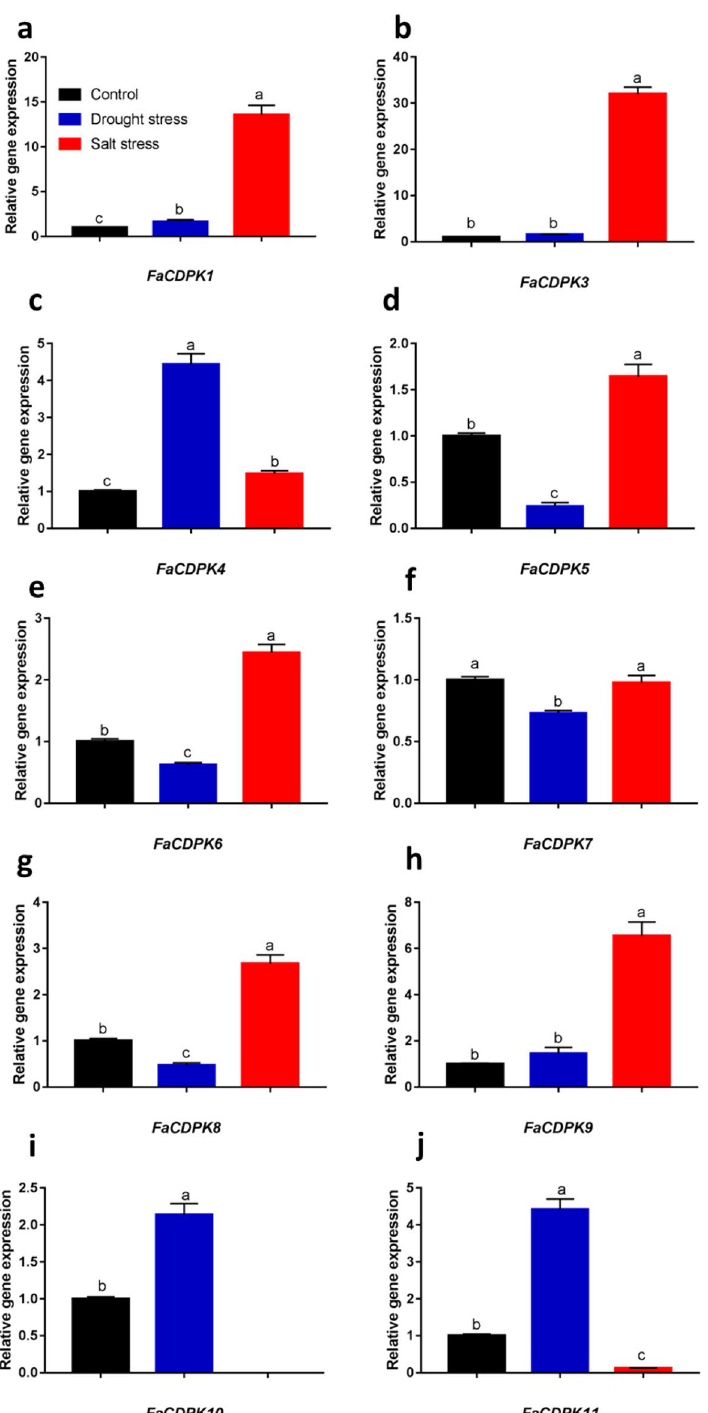
Figure 5. Expression of calcium-dependent protein kinases (CDPK) under salt and drought stress treatment in Fragaria × ananassa . The expression level of PIRUV_DESCARB, DBP and HISTH4 was used as reference gene to normalize each reaction. The data was from four biological and three technical replicates. Data were subjected to one-way ANOVA test and when significant (p ≤ 0.05) were submitted to a comparison of means by Tukey test at 5% of probability. Different letters indicate significant differences between